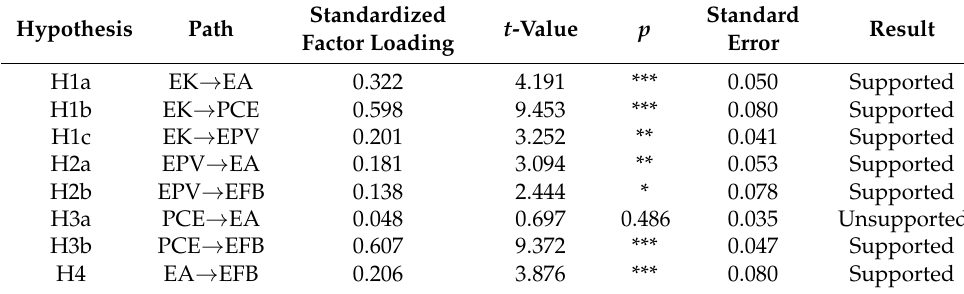
Figure 3. Structural equation model of the constructed theoretical model. Table 6. Results of hypotheses testing using the modified model.